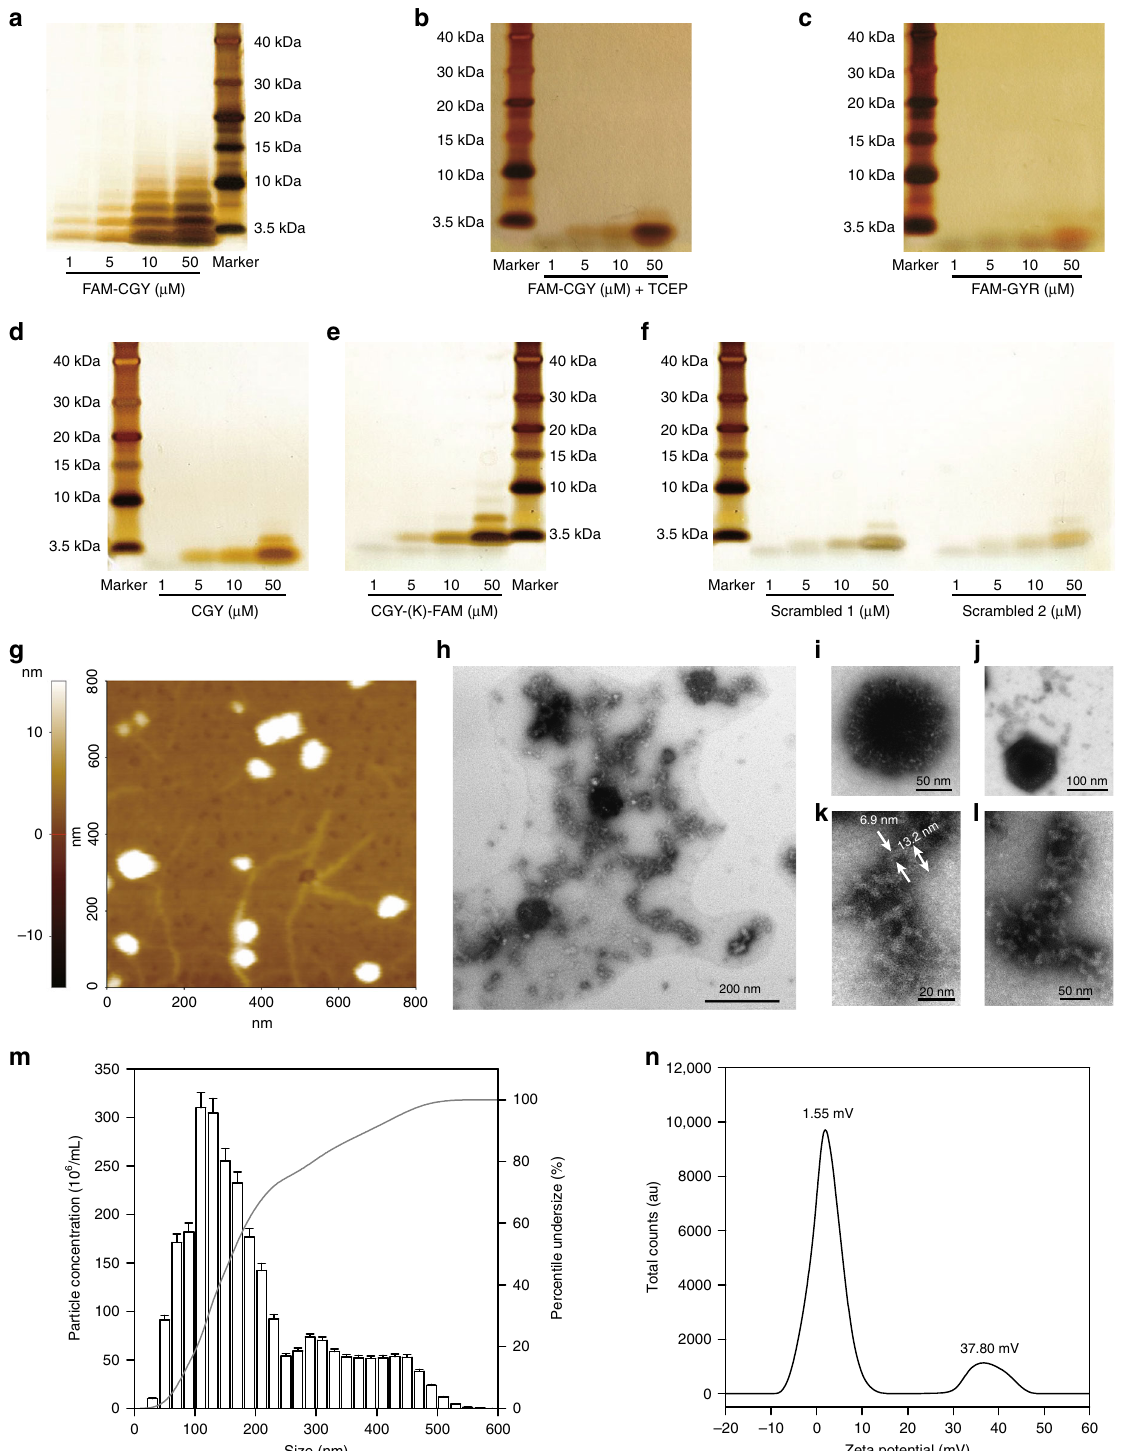
Fig. 1 FAM-CGY assemblies and their characterisation. a Non-reducing SDS-PAGE of FAM-CGY at different concentrations showing oligomer formation at >5 µ M. b SDS-PAGE of FAM-CGY in the presence of tris(2-chloroethyl) phosphate (TCP), which reduces cysteine to free thiol and prevents FAM-CGY dimer and oligomer formation. c – f SDS-PAGE analysis of FAM-GYR, CGY and other analogues, showing absence of oligomers. Peptide sequences are depicted in Table 1. Molecular weight markers are shown in each gel (last lane in a and e and fi rst lane in other gels). g Representative topographic atomic force microscopy images of FAM-CGY assemblies. The image shows the presence of both nanoparticles and fi bre-like structures (white threads). h Representative electron micrographs of FAM-CGY assemblies showing the presence of electron dense nanoparticles and branched- fi bres. i Magni fi ed electron micrograph of a typical nanoparticle, where tightly packed proto fi lament projections forms the shell. j Shows a nanoparticle with surface projected fi bres. k , l Representative magni fi ed views of twisted nano fi bres. m A typical size distribution pro fi le of FAM-CGY NLCs as a function of particle concentration determined by nanoparticle tracking analysis. n Calculated zeta potential values of FAM-CGY NLCs from electrophoretic mobility measurements. Each experiment was repeated three times with different preparations of FAM-CGY ( n = 3) with identical